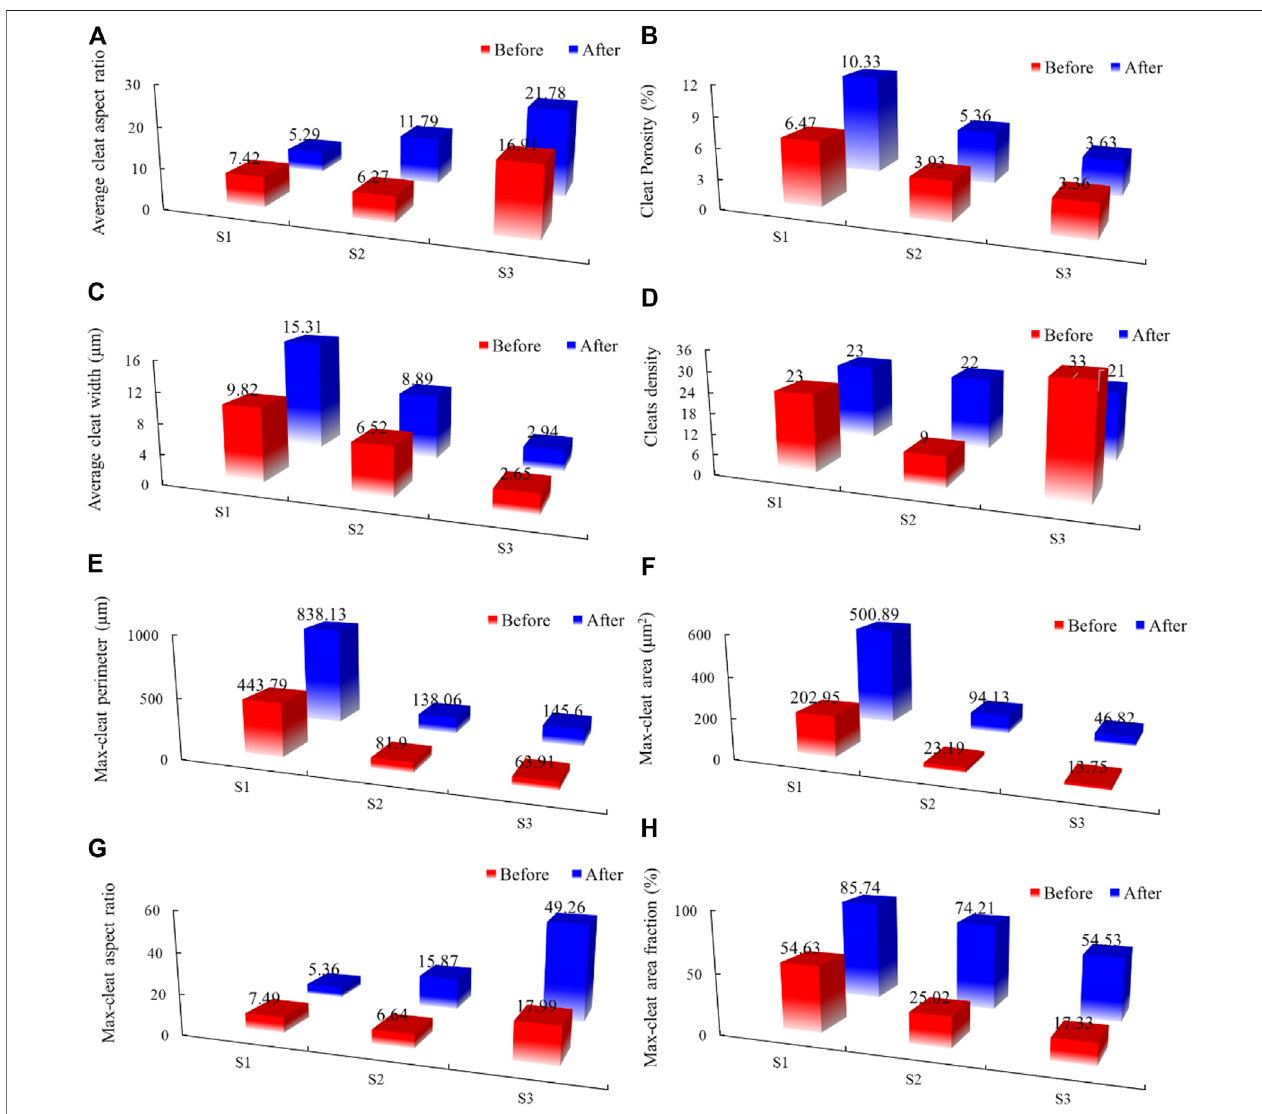
FIGURE 4 | Histogram of the variation of cleat parameters in coal: (A) total aspect ratio; (B) porosity; (C) average width of all cleats; (D) fracture density; (E) perimeter; (F) area; (G) aspect ratio of maximum cleat; (H) the maximum cleat fraction.